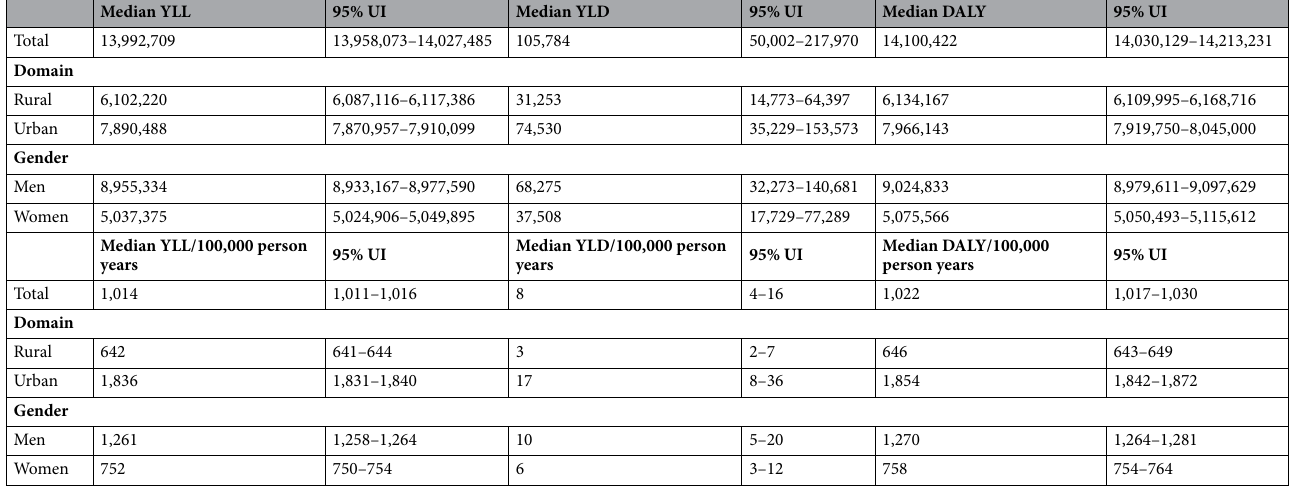
Table 1. Estimated annual disability adjusted life years (DALYs) due to excess COVID-19 deaths in 2020 in India. 95% UI = 2.5–97.5th